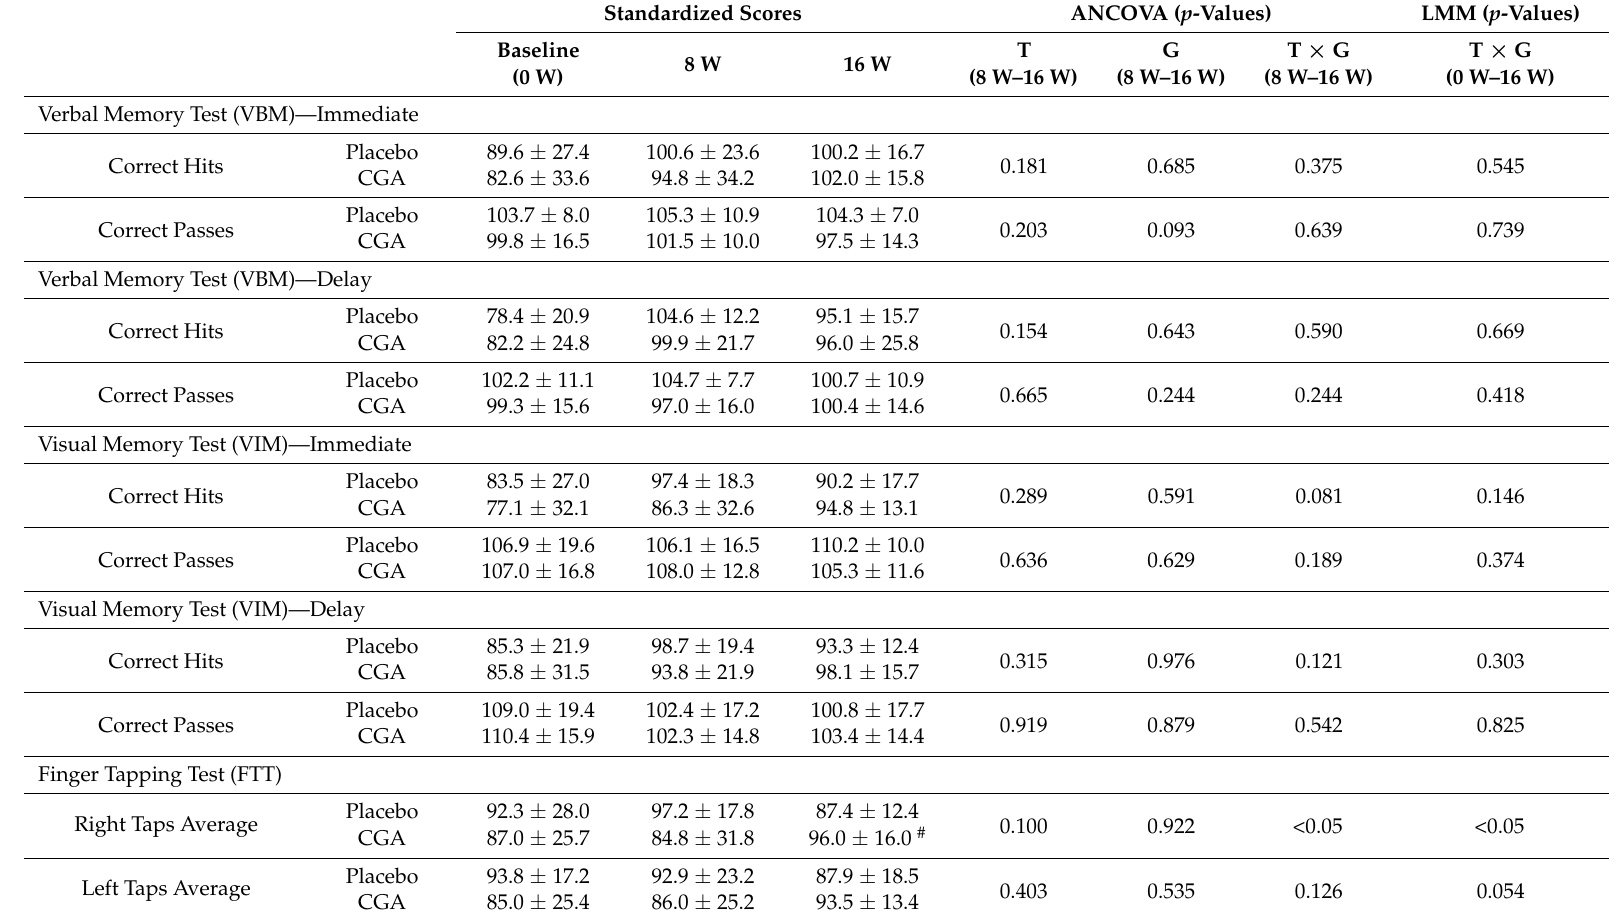
Table 4. The scores of individual tests in